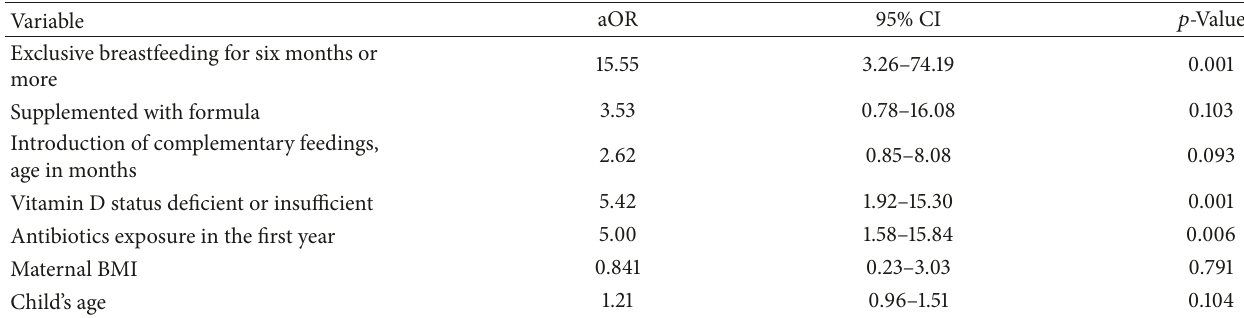
Table 5: Multivariate logistic regression analysis to assess independent relationships between FA status and early exposures during infancy in